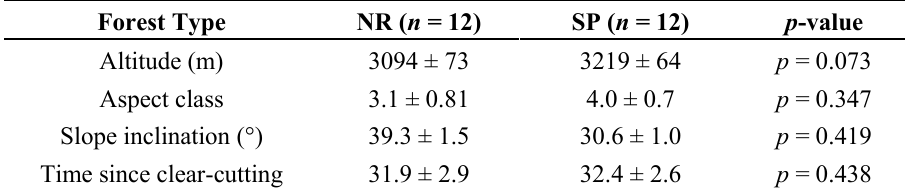
Table A1. Characteristic of naturally regenerated (NR) and reforested spruce plantations (SP) stands originating from similar clear-cuts in the eastern Tibetan Plateau. Differences between NR and SP plots were tested by independent t -test.